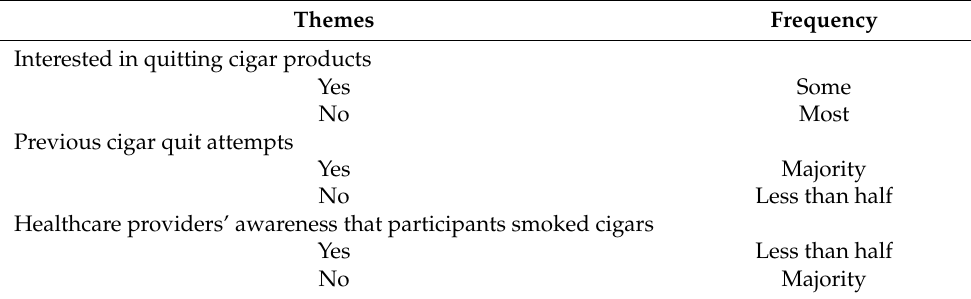
Table 2. Reported themes by estimated